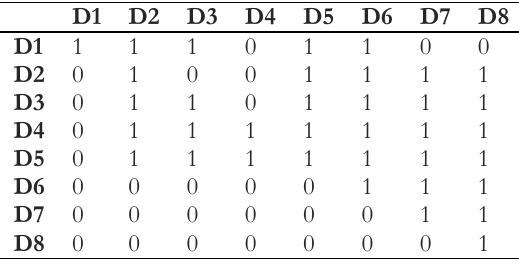
Table 2. Adapted acquisition matrix dimensions of RL AIRQUAL service quality